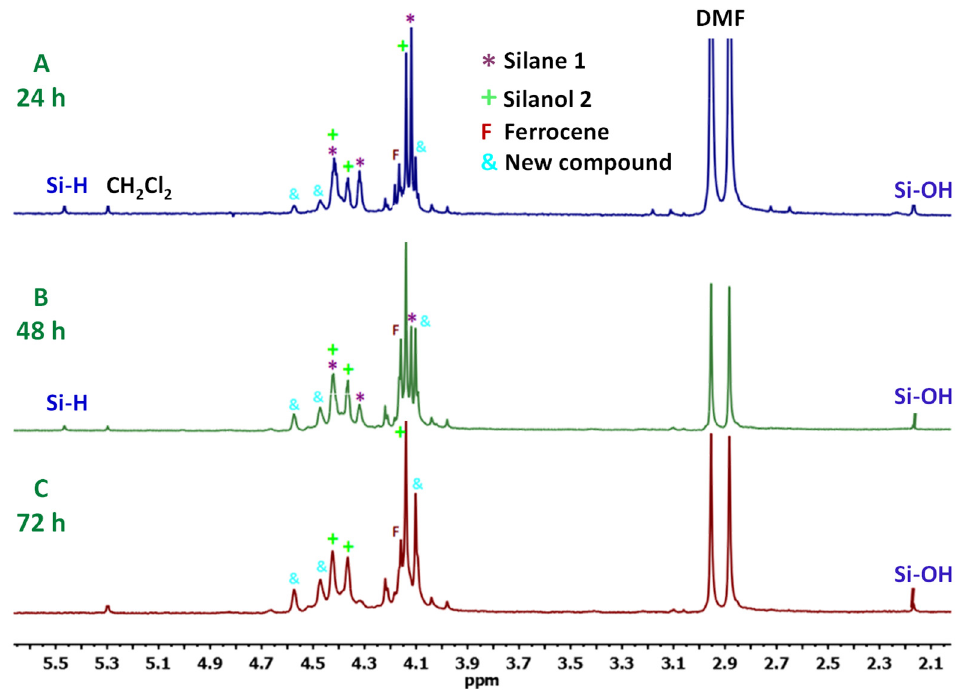
Figure 1. 1 H NMR spectra (CDCl 3 , 300 MHz) of the reaction between silane 1 and DMF, with Mo(CO) 6 as a catalyst, after 24 ( A ), 48 ( B ), and 72 ( C ) h.